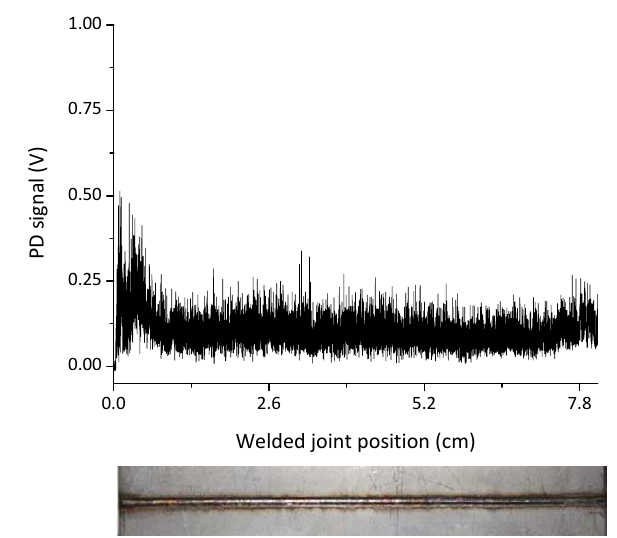
Figure 2. (a) Photodiode signal corresponding to a defect-free weld (P = 1.8